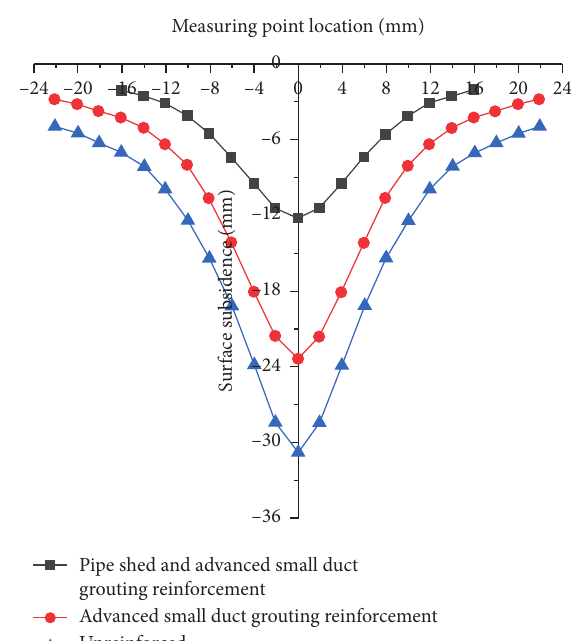
Figure 12: Distribution of surface settlement trough after the excavation of lower bench